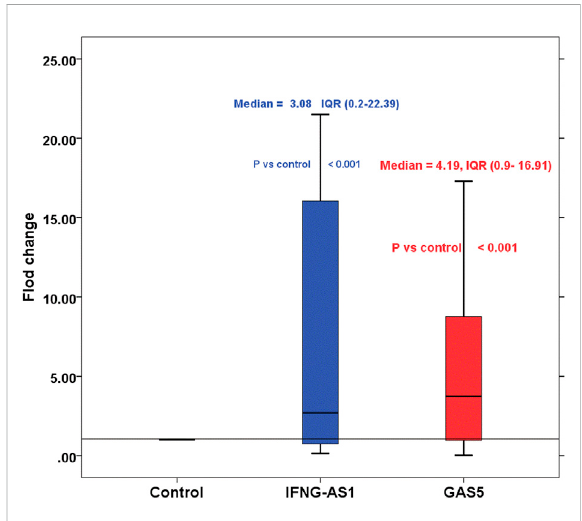
FIGURE 1 BoxplotrepresentsthefoldchangesoflncRNA IFNG-AS1 and GAS5 intheimmunethrombocytopenia(ITP)groupincomparison with the healthy control group. IFNG-AS1 : Mean ± SD = 18.37 ± 19.54, median (IQR) = 3.08 (0.2 – 22.39), GAS5 : Mean ± SD = 6.17 ± 11.33, median (IQR) = 4.19 (0.9 – 16.91). Control was set as one according to 2 − ΔΔ Ct